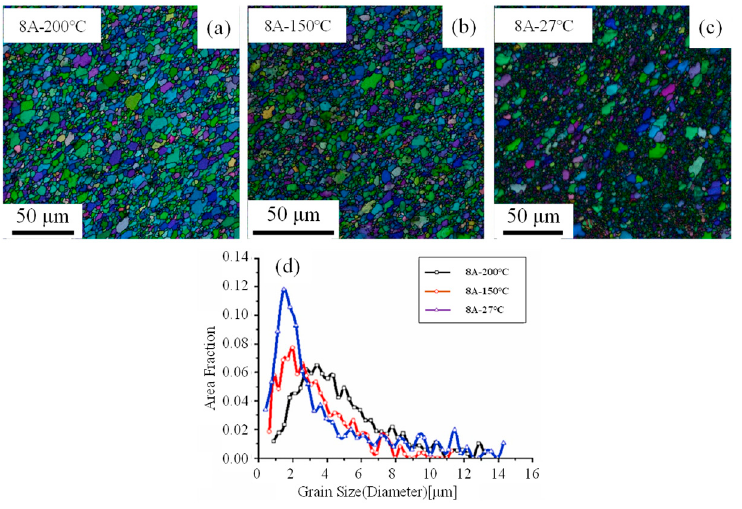
Figure 7. Inverse pole plot at different temperatures [50]: ( a ) 200 °C; ( b ) 150 °C; ( c ) 27 °C; ( d ) is the area fraction particle size distribution at different temperatures. Reproduced with permission from Elsevier B.V.